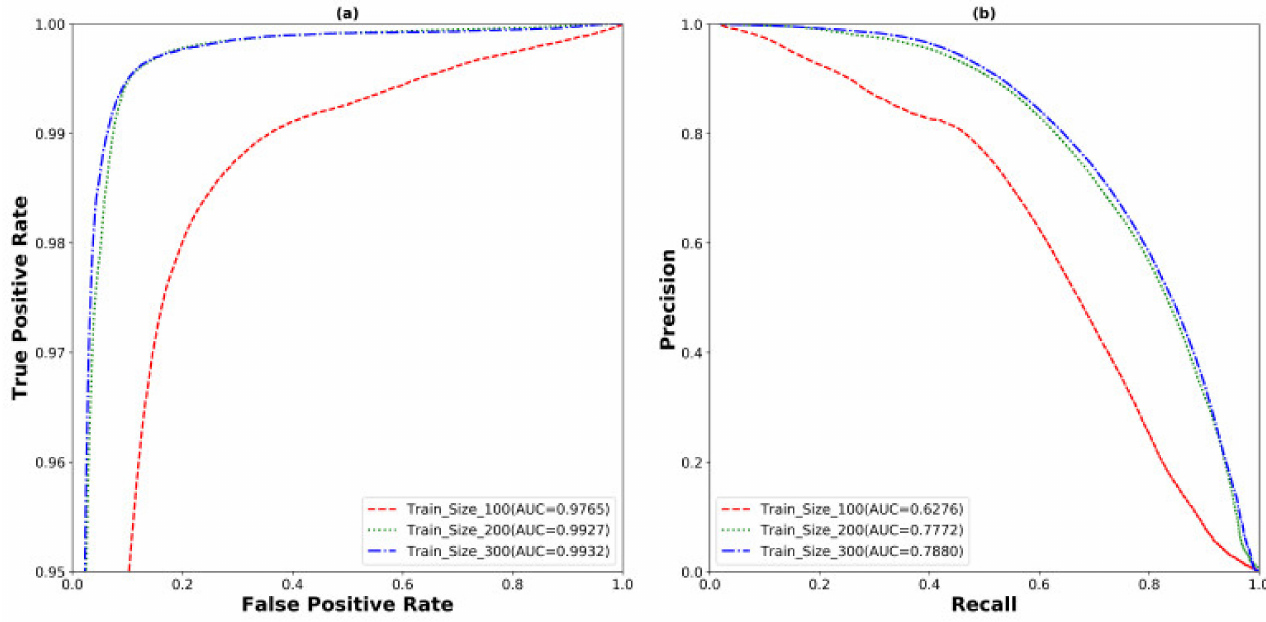
Figure 9. The ( a ) ROC and ( b ) PR curve for the experiment of different training sizes. Table 4. A performance comparison of U-Net in different train sizes (bold represents the best performance). Model